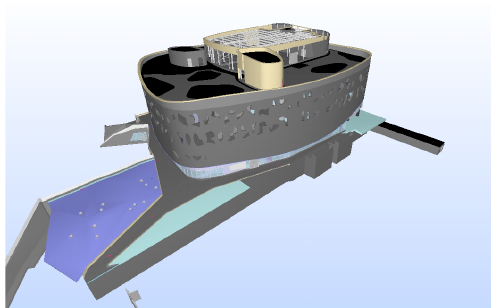
Figure 13. IFC model from As-built BIM, Bergeron Building